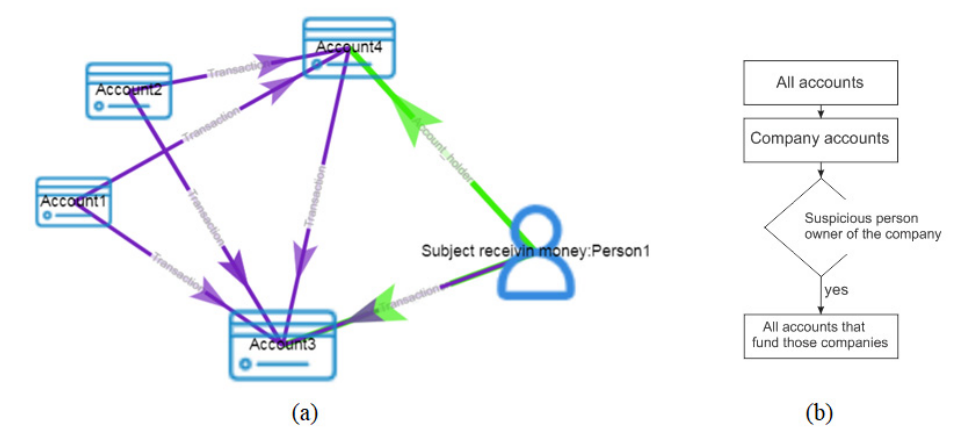
Figure 3. ( a ) All the accounts from which the transfers have been executed and ( b ) the flowchart of the Cypher query.